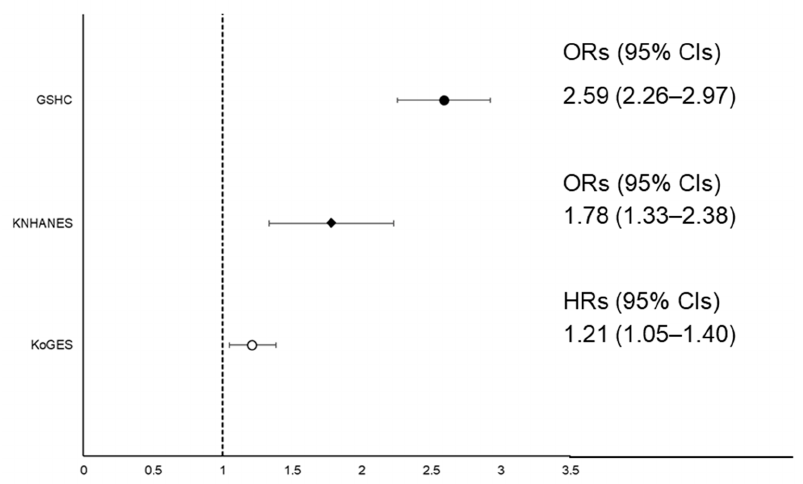
Figure 2. Forest plot of ORs or HRs with 95% CIs for low skeletal muscle mass index (LSMI) ac- cording to NAFLD status. Abbreviations: HRs, hazard ratios; ORs, odds ratios; CIs, confidence intervals; LSMI, low skeletal muscle mass index; NAFLD, non-alcoholic fatty liver disease; KNHANES, Korean National Health and Nutrition Examination Survey; KoGES, Korean Genome and Epidemiology Study.